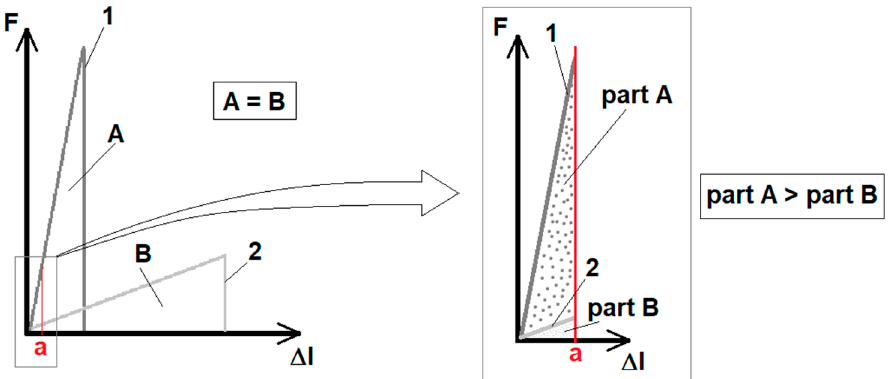
Figure 9. Schematic illustration of the influence of the strain rate on the resistance energy of a loaded material: 1—F- Δ l curve for a brittle and rigid (without plastic deformation) material loaded with a high strain rate, 2—F- Δ l curve for a similar sample of the same material loaded with a lower strain rate; A—the energy of destruction of a sample deformed at a higher speed, B—energy of destruction of a sample deformed at a lower speed; part A—deformation energy of the sample deformed at a higher speed on the displacement section limited by a value of a, part B—strain energy of a sample deformed at a lower speed over the displacement distance limited by a value of a.